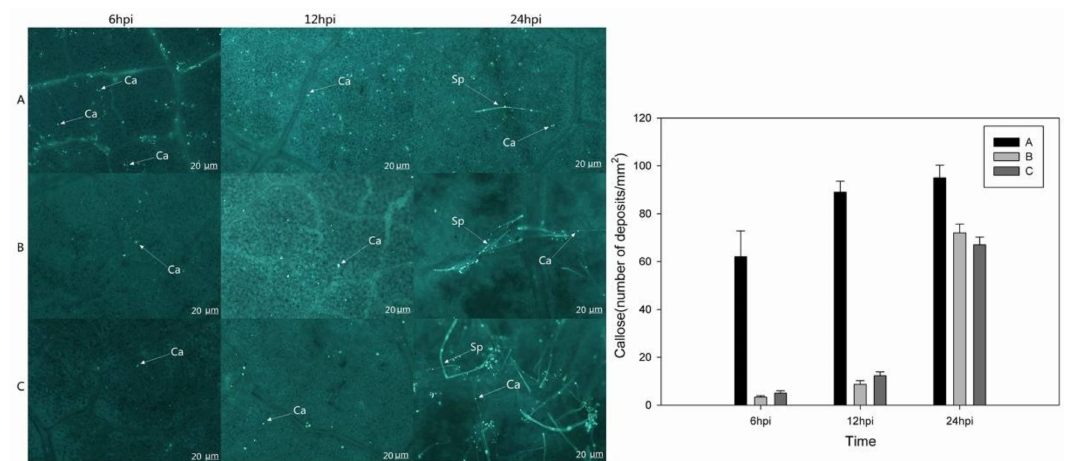
Figure 10. Microscopic assessment and statistics of callose deposition in the leaves of Vitis vinifera after inoculation with Plasmopara viticola . ( A ) V. vinifera expressing VaHAESA ; ( B ) V. vinifera transformed with the empty vector (pBI121); ( C ) untransformed V. vinifera ‘Thompson Seedless’. Representative images were taken 6, 12, 24, and 48 h post-infection (hpi). Ca: Callose, Sp: